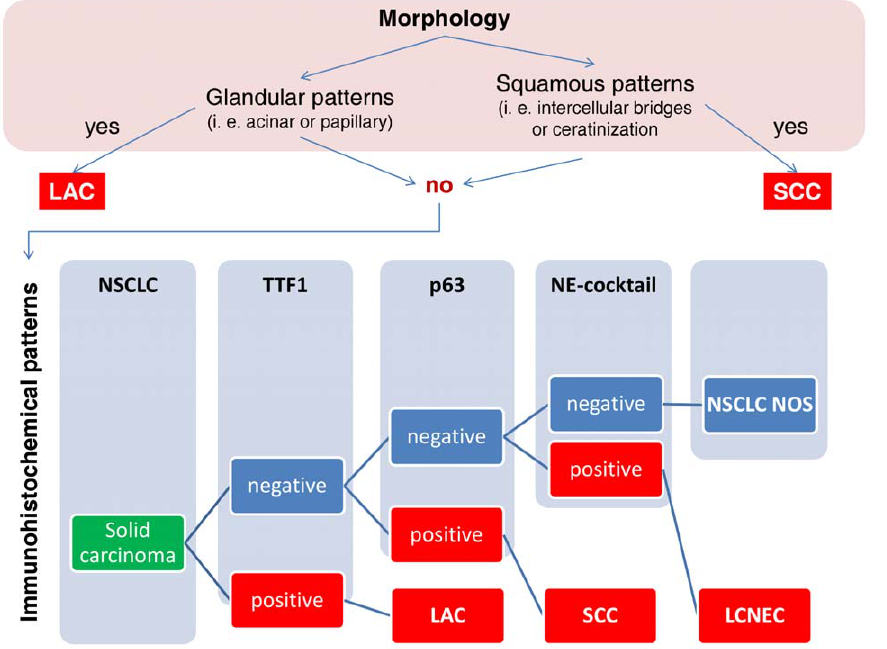
Figure 1. Hierarchical classification of NSCLC using evaluation of growth patterns followed by expression of IHC markers.